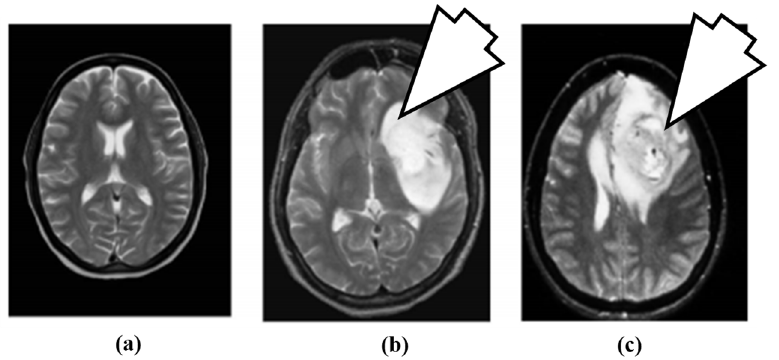
Figure 4. Brain MR images: ( a ) normal brain, ( b ) benign tumor (7 O’ clock arrow) and ( c ) malignant tumor (7 O’ clock arrow) (reproduced from [63] with permission).